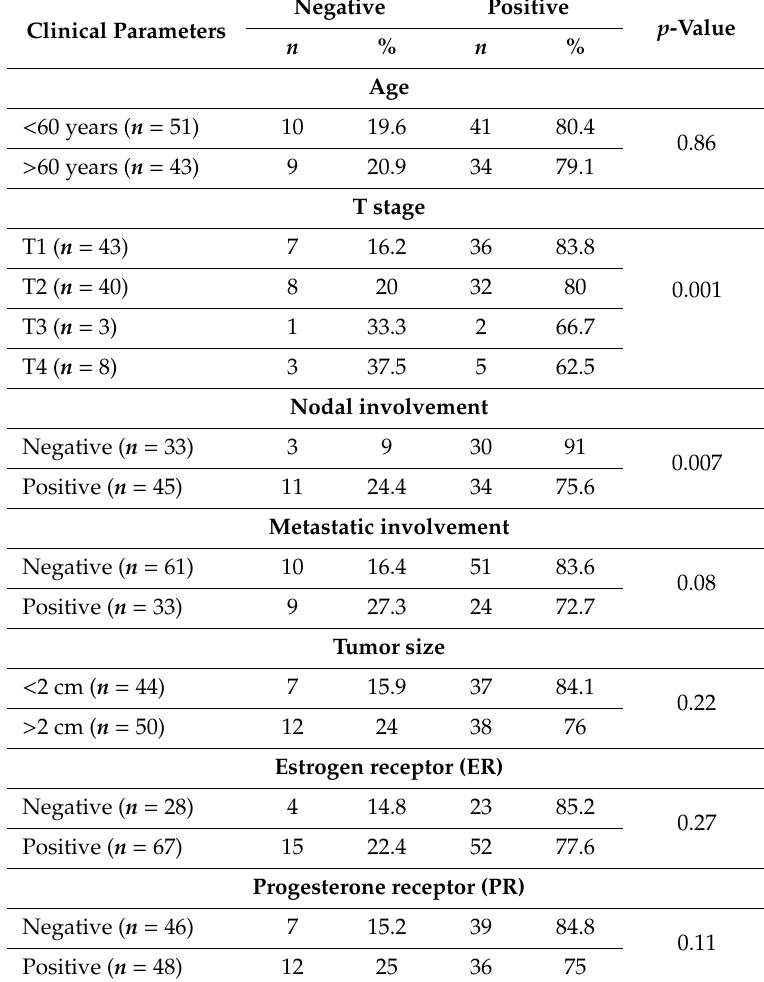
Table 1. Relationship between CrkL expression and pathological parameters in clinical breast tumor